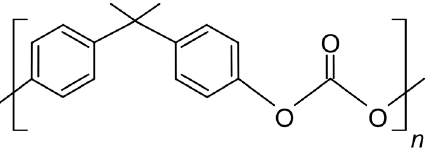
Figure 2. Structure of poly(bisphenol A carbonate).